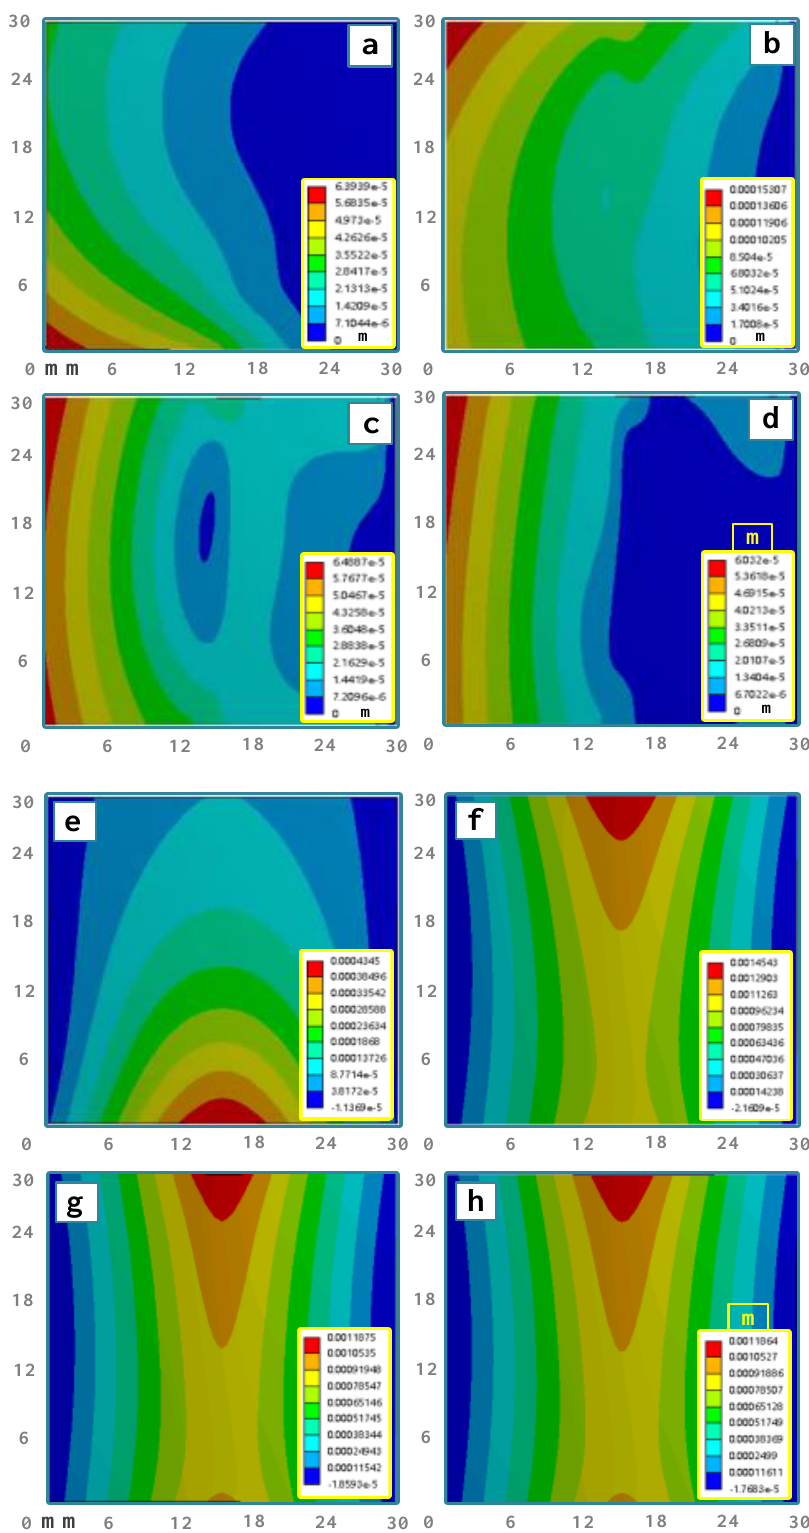
Figure 7. Cloud chart of z -direction displacement at different time: ( a ) t = 3 s (traditional method), ( b ) t = 33 s (traditional method), ( c ) t = 63 s (traditional method), ( d ) t = 93 s (traditional method), ( e ) t = 3 s (BPM), ( f ) t = 33 s (BPM), ( g ) t = 63 s (BPM) and ( h ) t = 93 s (BPM).